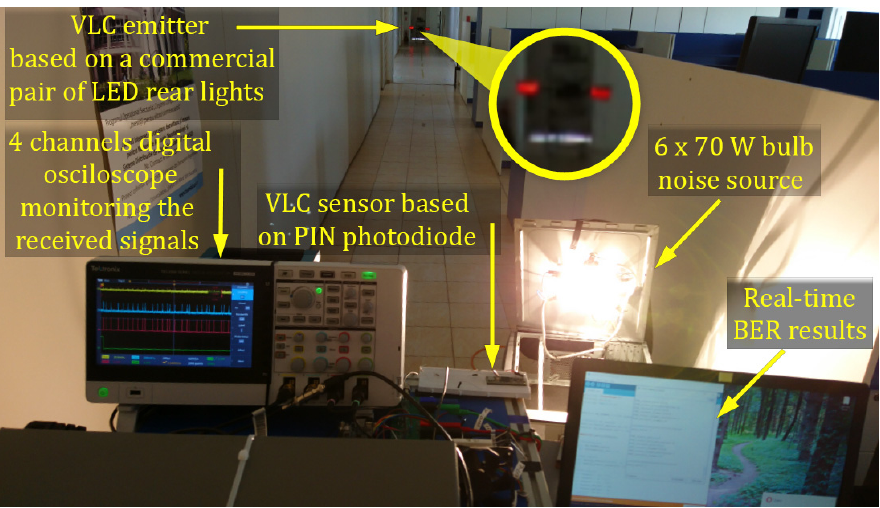
Figure 12. Indoor experimental setup. Figure 12.